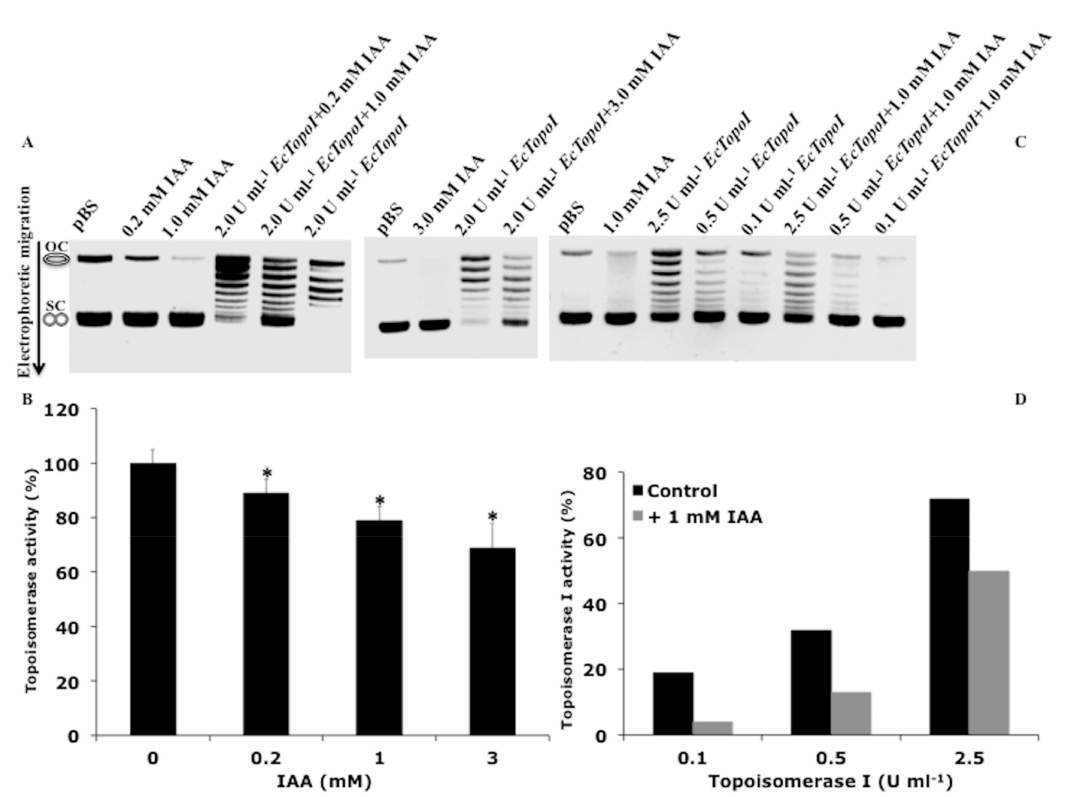
Figure 4. IAA influences the topoisomerase I activity. ( A ) and ( B ) E ff ect of 0.2, 1.0, and 3.0 mM IAA on the activity of 2.5 U mL − 1 topoisomerase I from E. coli ( EcTopoI ). ( C ) and ( D ) E ff ect of 1.0 mM IAA on the activity of 0.1, 0.5, and 2.5 U mL − 1 EcTopoI . To visualize the reaction products, the gels were stained post-electrophoresis with ethidium bromide and de-stained in deionized water. The relative intensity of each band in the gel was measured and used to calculate the amount of total DNA (the unprocessed DNA plus the distinct topoisomer species), and that of all individual reaction products. For each condition, the relaxation activity is expressed as a percentage of the produced topoisomers over the total DNA in each lane. Values are the means ± SD of three di ff erent biological replicates. The asterisks (*) indicate significant di ff erences ( p < 0.05, one-way ANOVA with Tukey’s post-hoc test) between the control and IAA-treated DNA samples. OC, open-circular DNA; SC, supercoiled